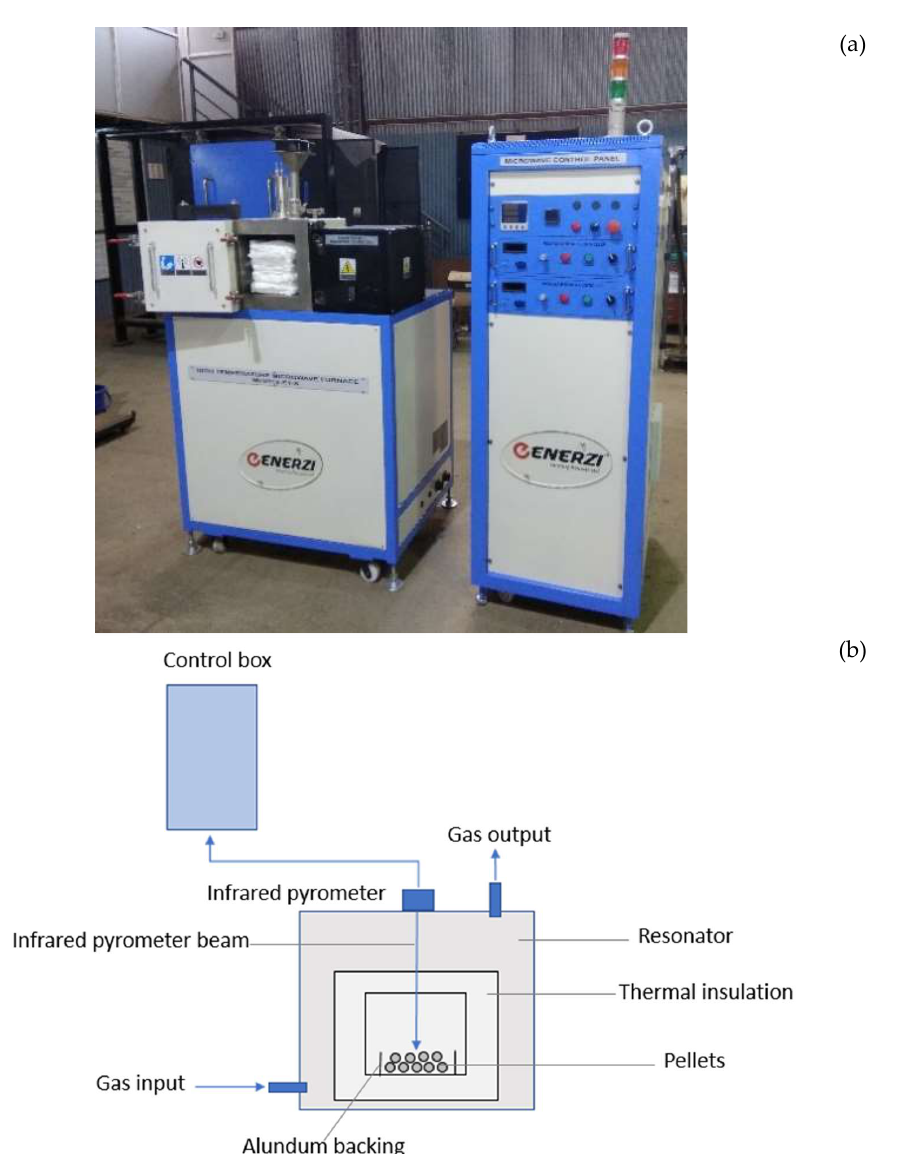
Figure 1. Experimental microwave oven for sintering fuel pellets (model MH2918-E1-S, manufacturer—Enerzi Microwave Systems Pvt. Ltd., Belgaum, India) ( a ) and schematic layout of heat insulation and pellets inside the oven resonator ( b ).